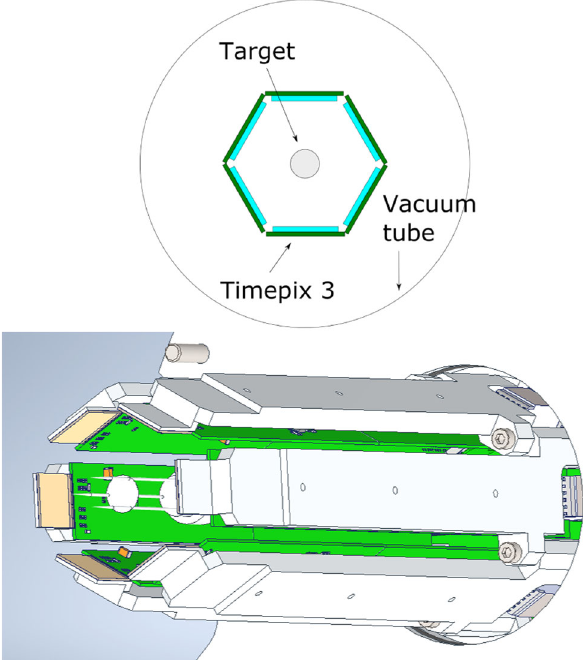
Fig. 12 Top: A hexagonal array of TPX3 detectors surrounding a tar- get. Bottom: CAD of the planned assembly to be inserted in a beam pipe with an outer diameter of 60